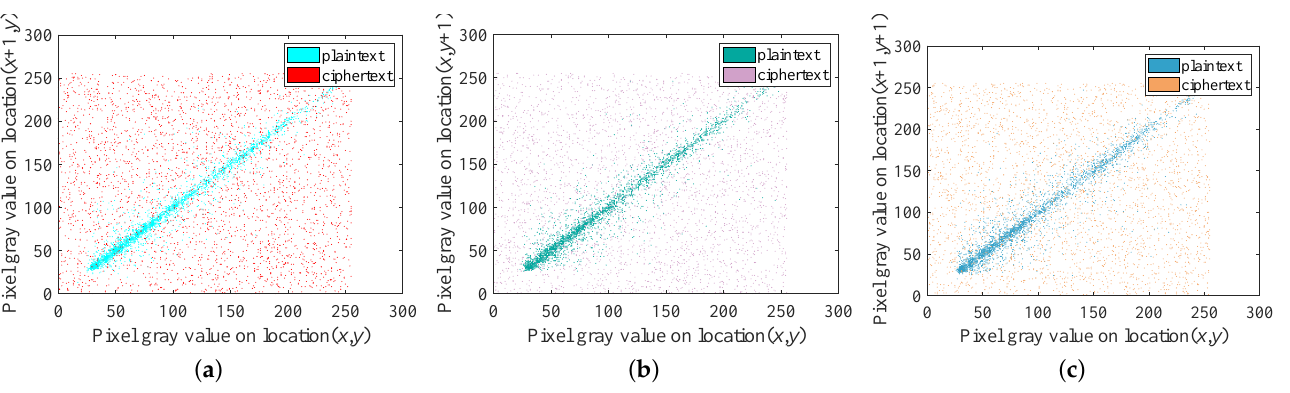
Figure 10. Adjacent pixels’ correlation of plaintext images and ciphertext images: ( a ) Horizontal correlation of plaintext images and ciphertext images; ( b ) Vertical correlation of plaintext images and ciphertext images; ( c ) Diagonal correlation of plaintext images and ciphertext images.